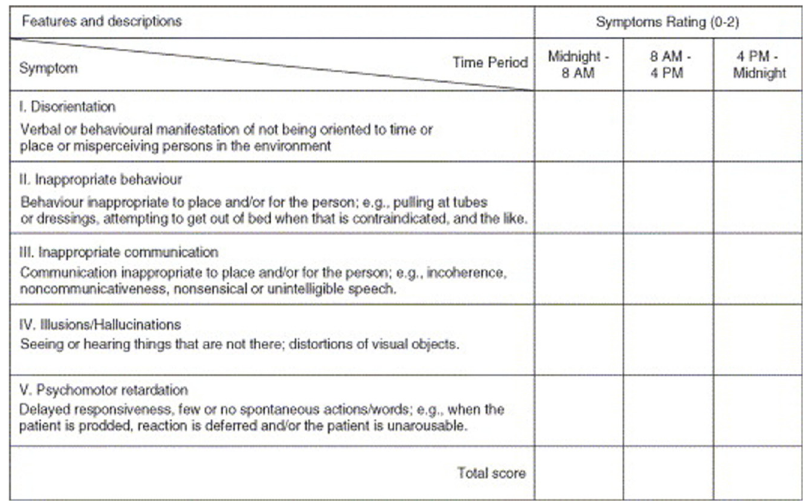
Figure A2. The Nu-DESC score.